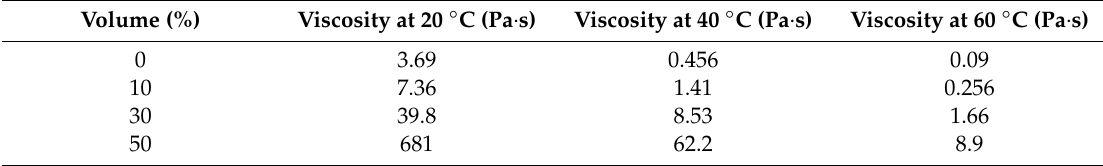
Table 3. Experimental results of fly ash filled epoxy composite at di ff erent temperature. Volume